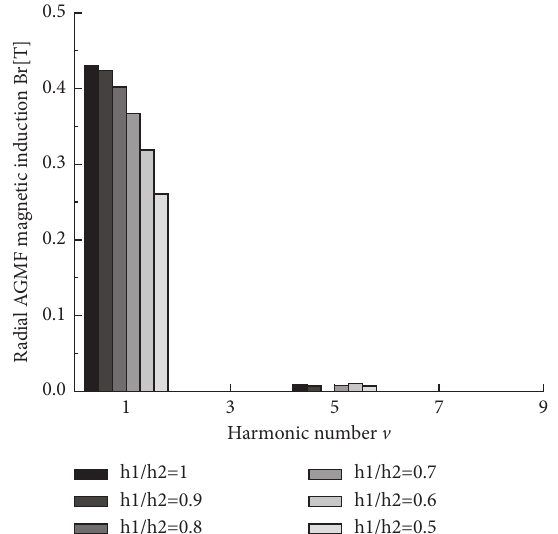
Figure 8: Harmonic analysis of magnetic induction intensity in radial AGMF at different h 1 / h 2